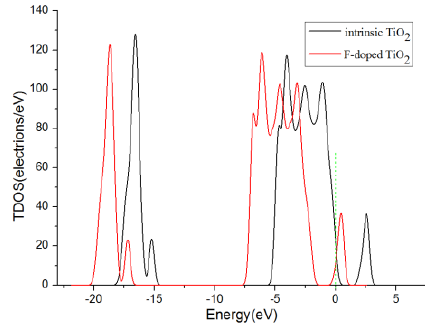
Figure 3. The curves of the density of states of F-doped TiO 2 and intrinsic anatase TiO 2 (101) perfect crystal plane, the green short dashed line is Fermi level.